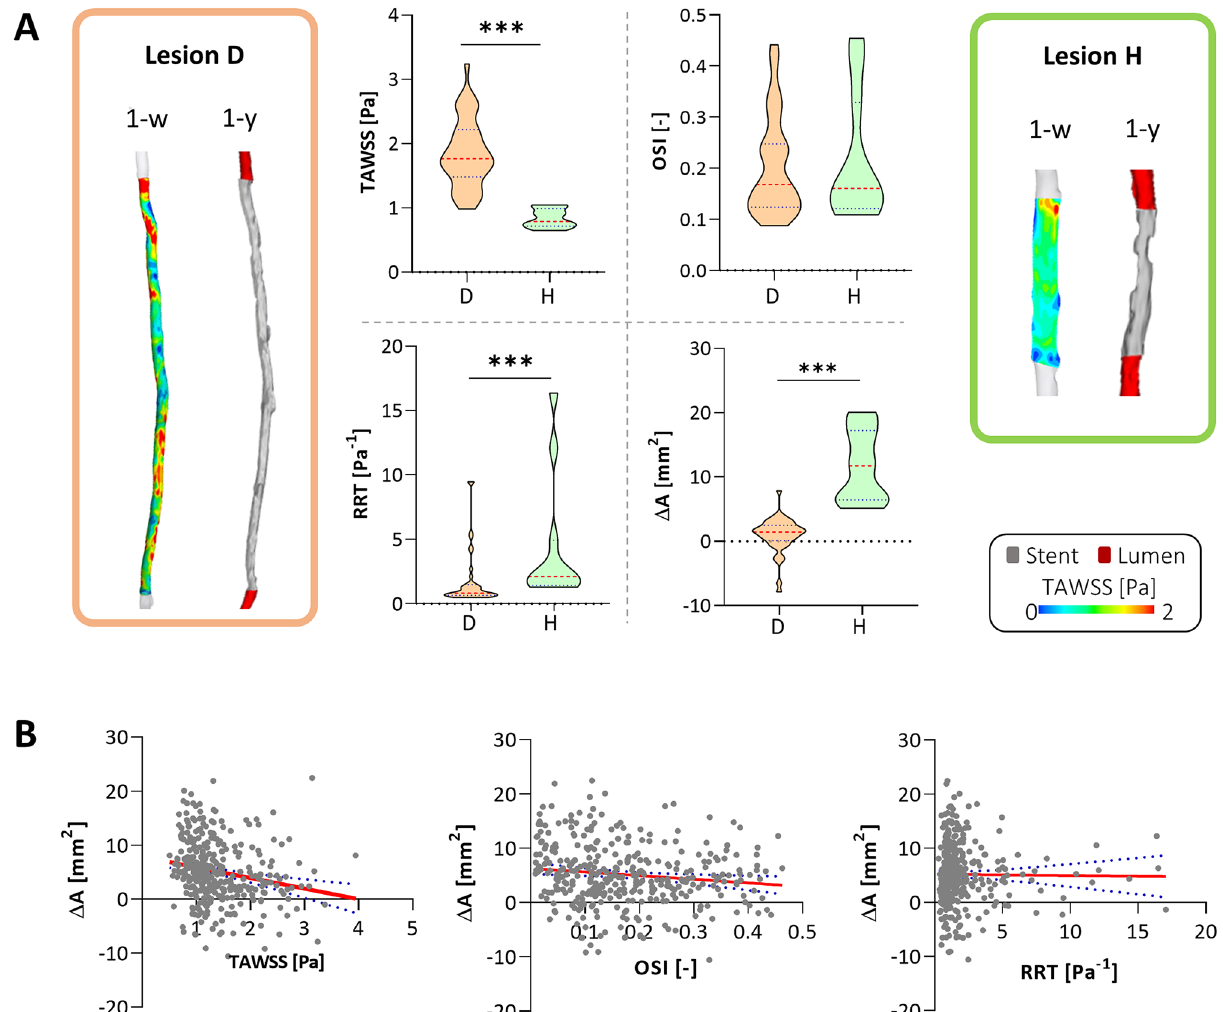
Figure 5. Results of the local analysis. ( A ) Comparison between the lesions presenting the lowest and the highest correlation coefficient between time-averaged wall shear stress (TAWSS) and lumen area change (lesions D and H, respectively). For both lesions, the contour maps of TAWSS computed at 1-week and the geometrical model at 1-year are shown. The violin plots, showing the distribution, median, and quartiles of each hemodynamic descriptor (TAWSS, oscillatory shear index—OSI and relative residence time—RRT) and lumen area change (ΔA), are represented. ( B ) Linear regressions between each hemodynamic descriptor and ΔA. In this individual collective analysis, all the decorrelated results were collected in a unique dataset. ***p <